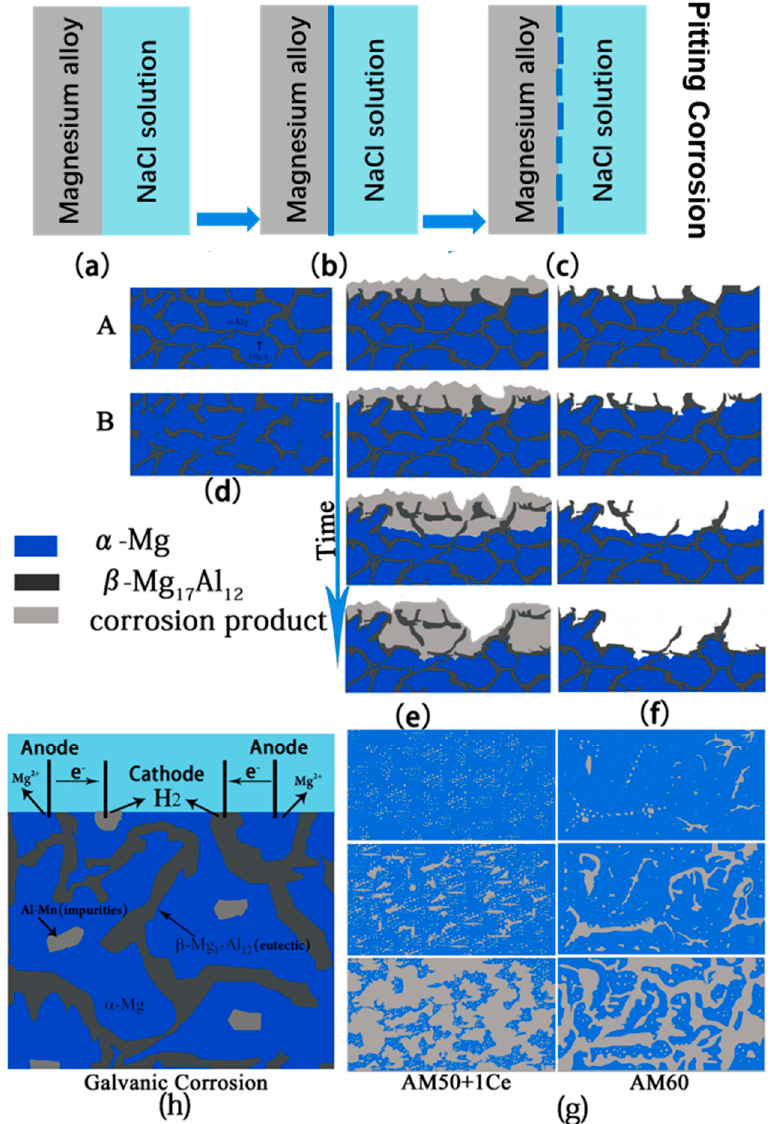
Figure 17. The schematic diagram of corrosion mechanism and morphology expansion model of HPDC AM50 + 1Ce and AM60 magnesium alloys in 3.5 wt% NaCl solution. ( a – c ) pitting process; ( d ) two type of second phase structure; the corrosion model before ( e ) and after ( f ) corrosion products cleaning; ( g ) corrosion propagation behavior of these two alloys and schematic diagram of galvanic corrosion.